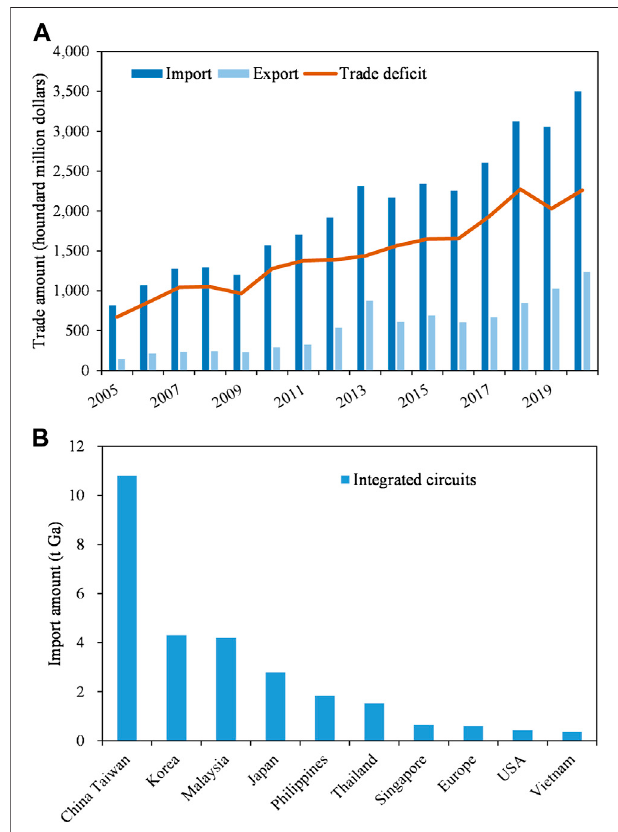
FIGURE 7 | (A) Trade volumes of China ’ s integrated circuits during 2005 – 2020 (B) Key exporters of gallium-containing intermediate products to China during 2005 –